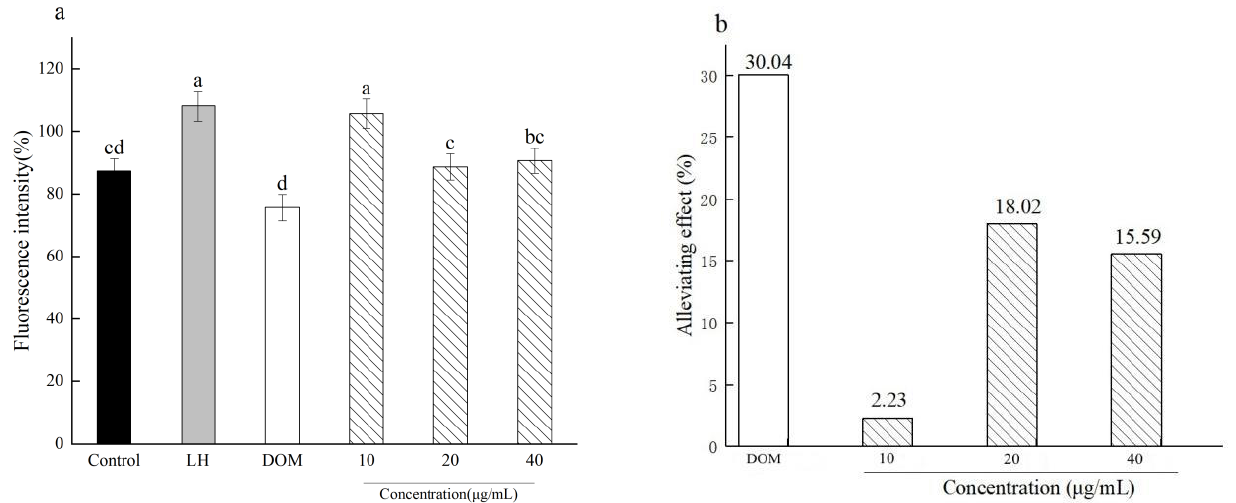
Figure 2. Alleviating effects of FWBP on intestinal motility inhibition in zebrafish ( p < 0.05). ( a ) Fluorescence intensity, %; ( b ) Alleviating effect, %. LH: loperamide hydrochloride; DOM: Domperidone. Different lowercase superscript letters denote statistically significant differences among different groups ( p <